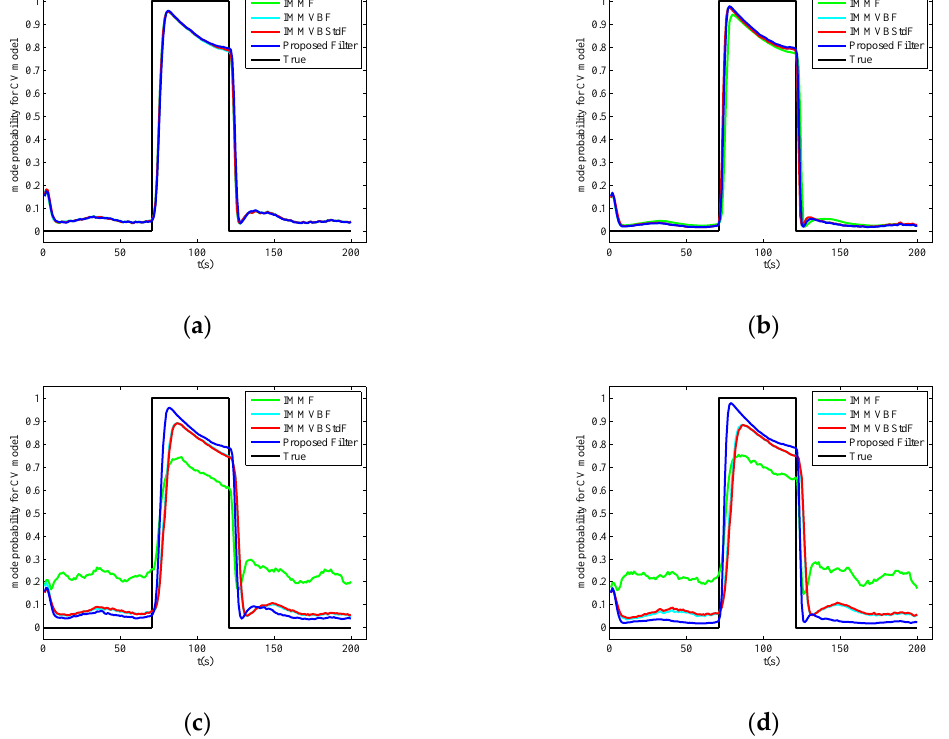
Figure 7. 1000 Monte Carlo runs averaged estimates of mode probabilities for constant velocity model in four cases. ( a ) Case A; ( b ) Case B; ( c ) Case C; ( d ) Case D.